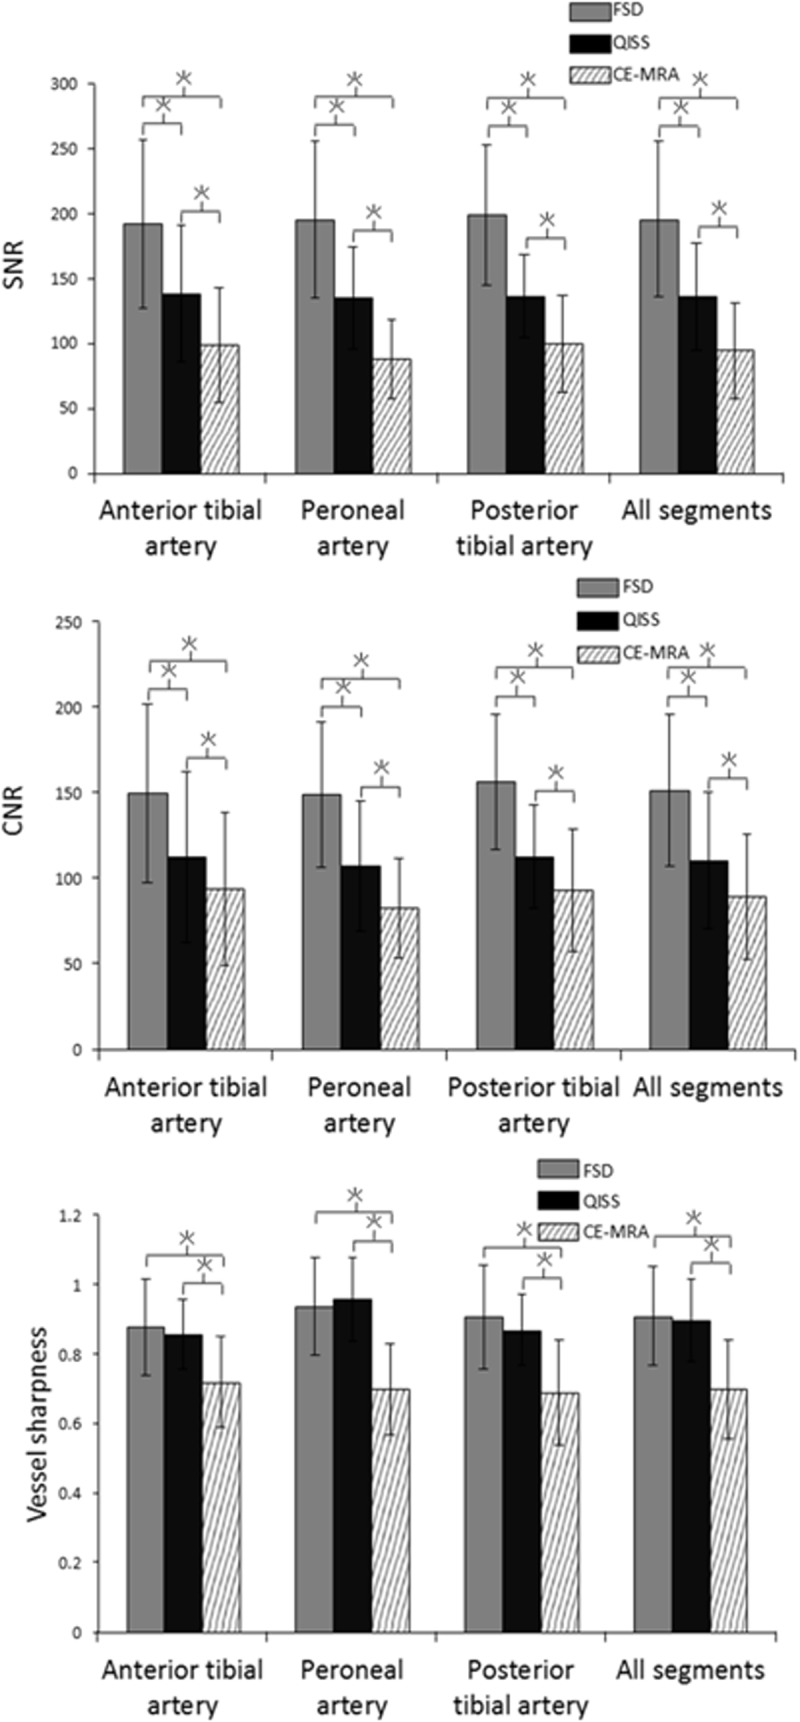
Comparison of SNR, CNR, and vessel sharpness between FSD, QISS, and CE-MRA in three arterial segments of the calf.Each column represents average measurements and error is shown as standard deviation. Asterisks indicated significant difference (P < 0.05). SNR: signal-to-noise ratio; CNR: contrast-to-noise ratio; FSD: flow-sensitive dephasing; QISS: quiescent-interval single-shot; CE-MRA: contrast-enhanced MR angiography.